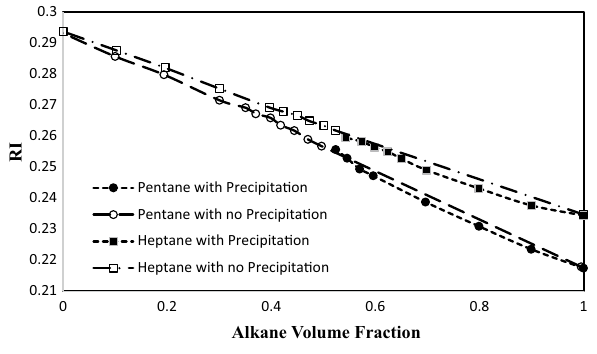
Fig. 15 Effect of different precipitants on RI of Mars crude oil–pre- cipitant mixture (Wattana et al.